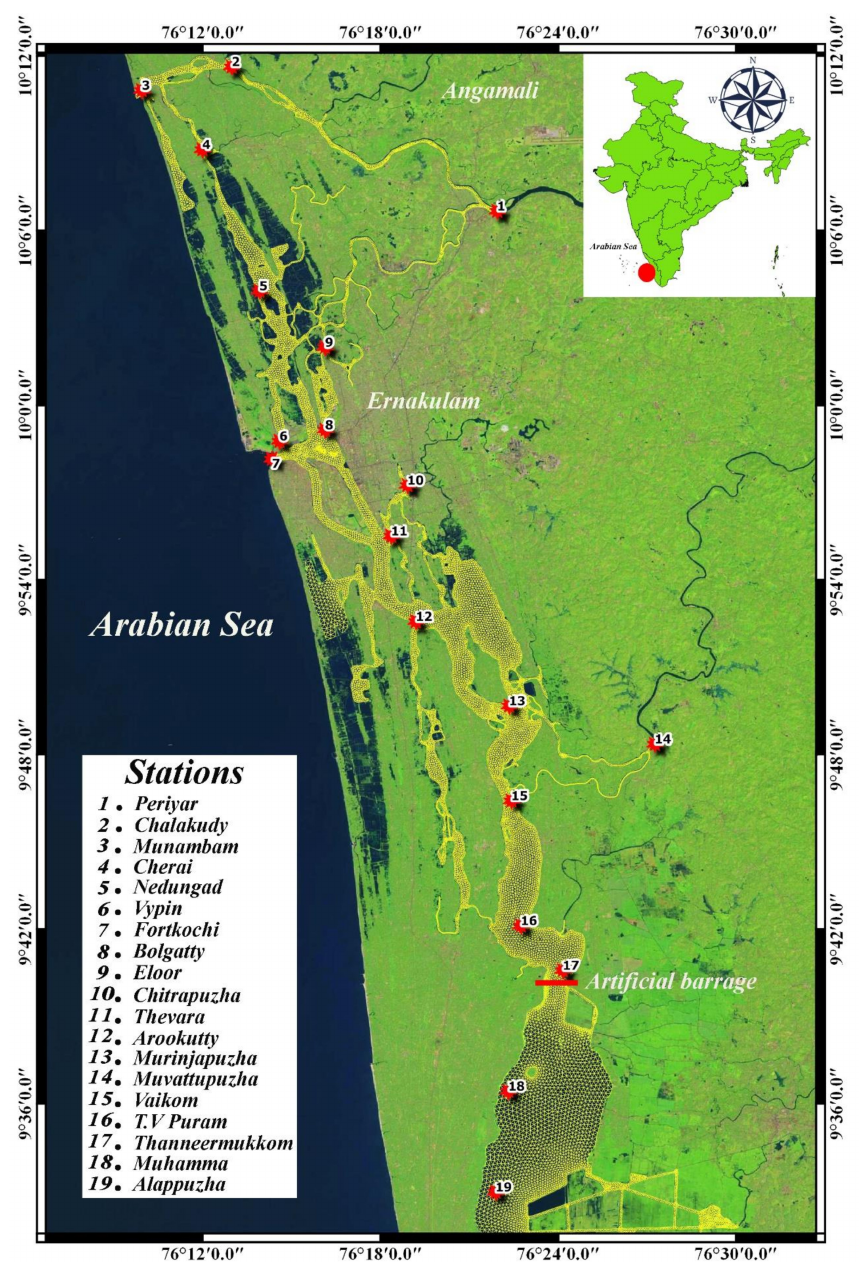
Figure 1. Cochin Estuary (CE) is situated in the state of Kerala (red filled circle in the in-site map), Southwest coast of India. This satellite (Landsat-8) image showed the model domain with the unstructured grid (yellow), and the major stations are numbered (1–19) on this map. An artificial barrage was constructed to prevent salt intrusion during the pre-monsoon period are marked by red line in this